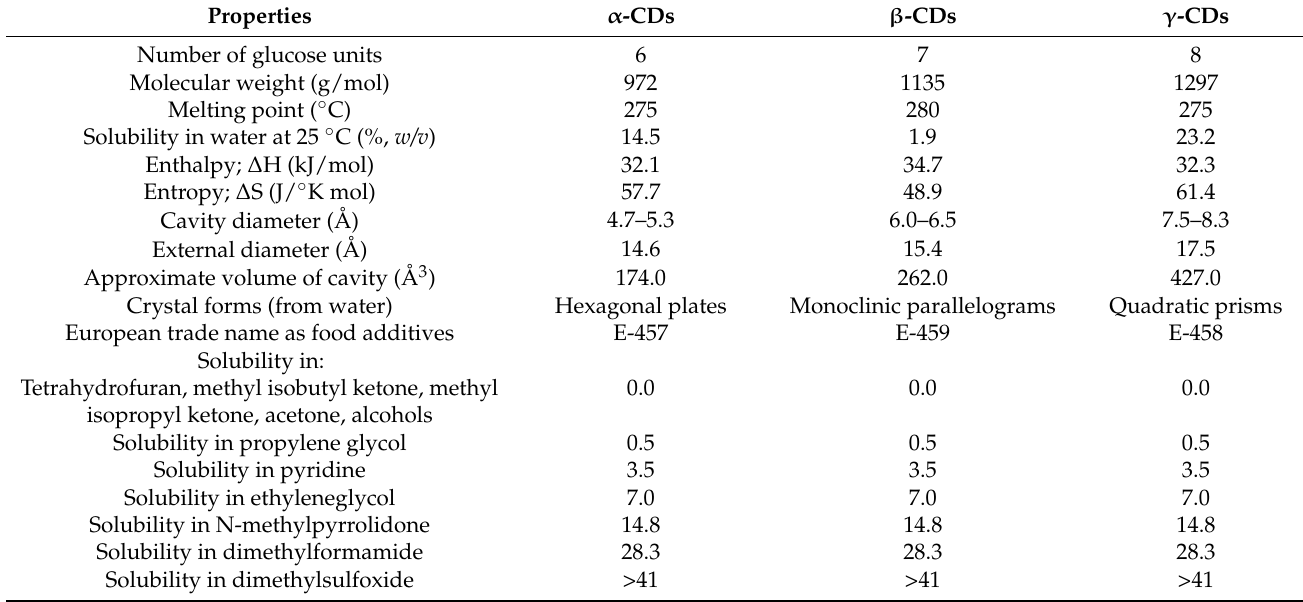
Table 1. Main physical and chemical properties of α -, β -, and γ -CDs. Data from